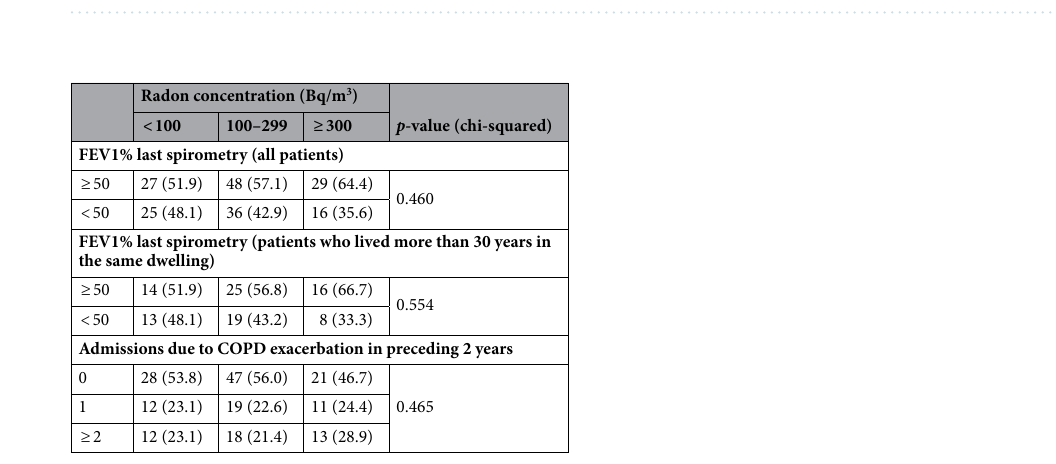
Table 2. Relationship between radon, FEV1% in last spirometry and admissions due to COPD exacerbation in preceding 2 years.